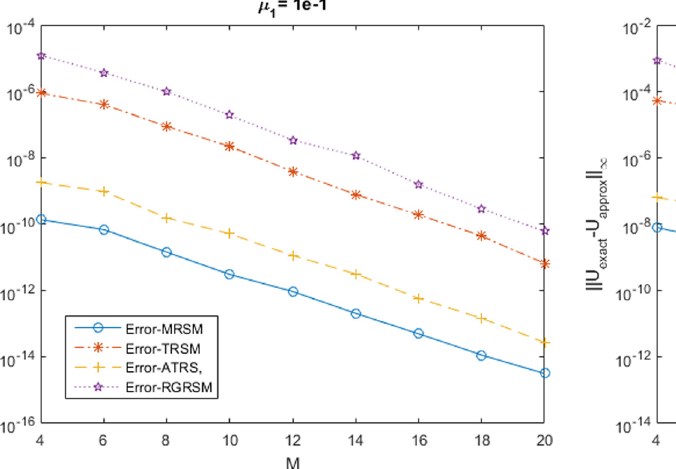
Figure 4: The absolute error of Example 4.1 by RSMs with t 0, 1 ( ] ∈ and M 4, 6,…, 20 = , and r −1, 1 ( ) ∈ and N 4, 6,…, 20 = at μ 0.1 1 = with α 1 = and β 1 = 2